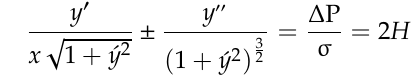
Figure 5. Schematic of a capillary bridge and geometric parameters.